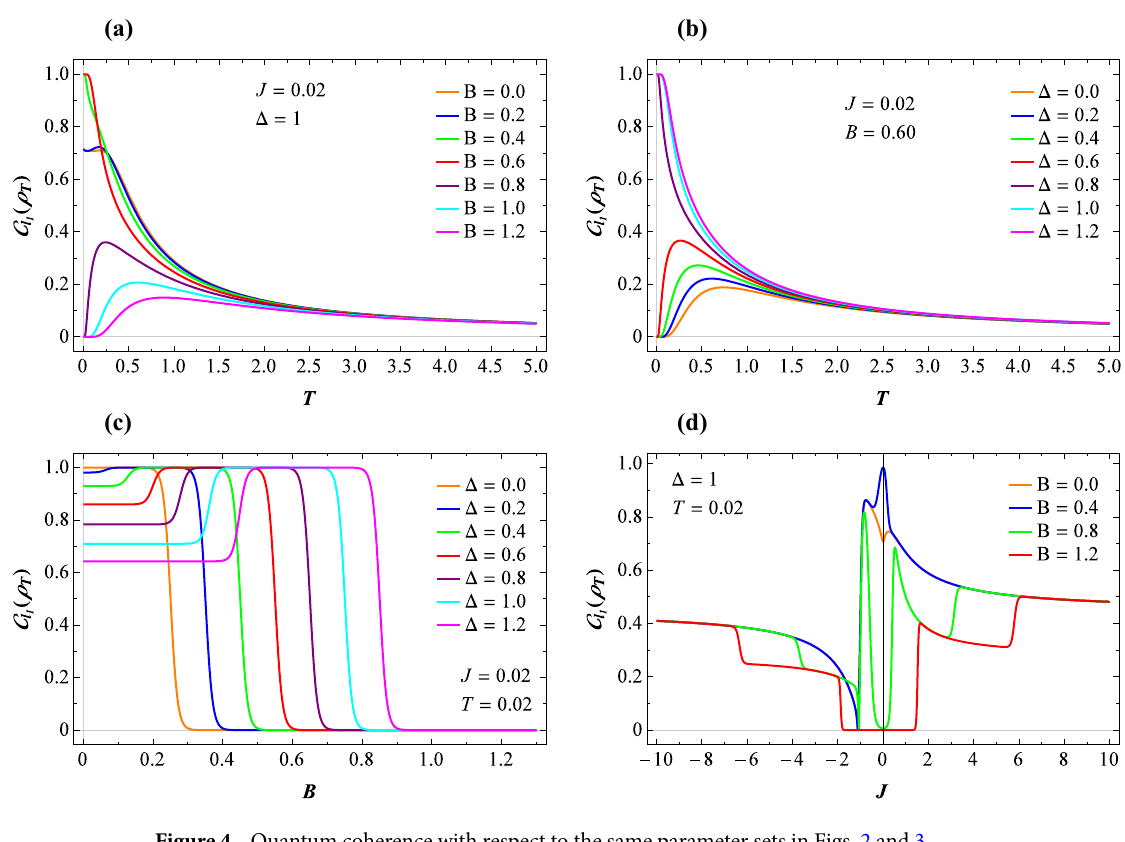
Figure 4. Quantum coherence with respect to the same parameter sets in Figs. 2 and